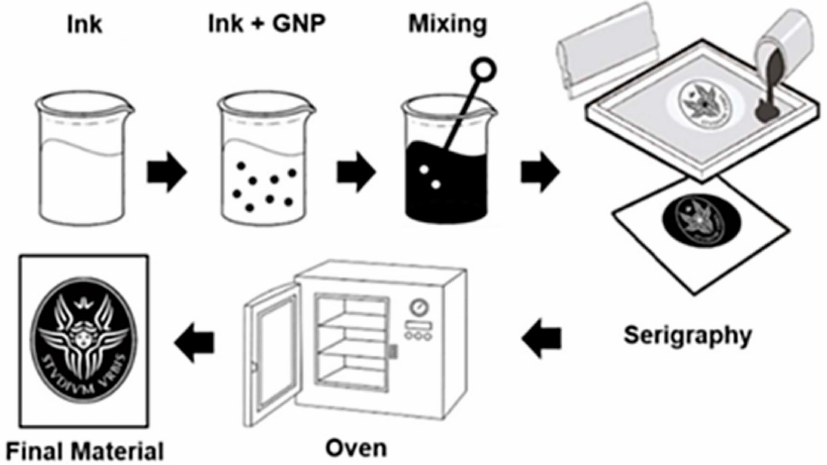
Figure 1. Production